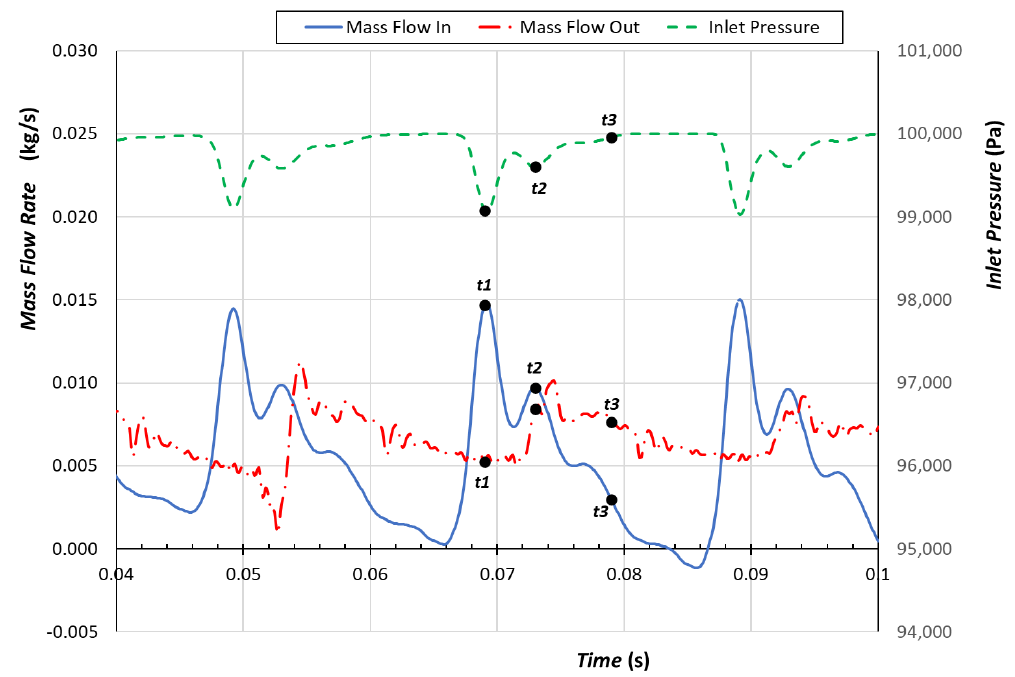
Figure 19. Evolution over time during the last three orbit revolutions of the rotating scroll of the: mass flow rate at the inlet port (blue solid line), mass flow rate at the discharge port (red dash-dot line) and pressure at the inlet port (green dotted line).